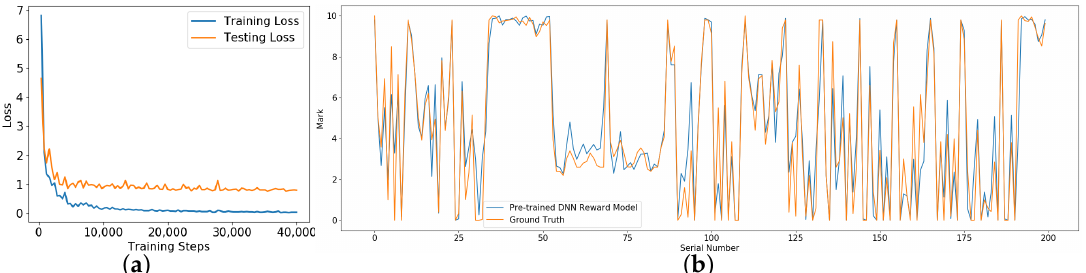
Figure 10. The performance of the DNN reward model in the virtual environment. ( a ) shows the loss curve on the training set and testing set; ( b ) shows the output of the DNN reward model (blue line) and the ground truth (orange line) while verifying the model in B → C